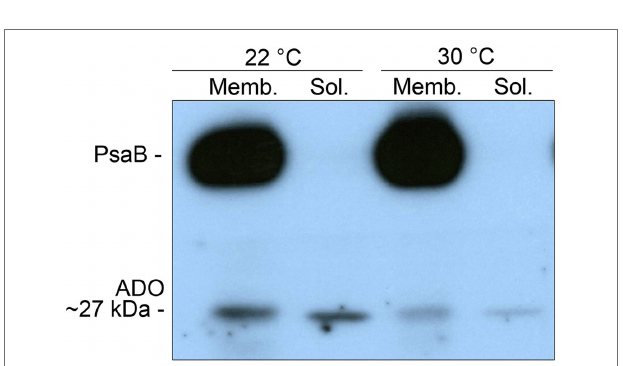
FIGURE 3 | Western blot analysis of ADO in the membrane fraction (Memb.) and the soluble fraction (Sol.) of Synechocystis sp. PCC 6803 cells cultivated at 22 ° C and 30 ° C for 4 days. The samples were loaded to the same final protein concentration (3 μ g) based on Bradford assay and analyzed using protein-specific antibodies against ADO, and the integral membrane reference protein PsaB. The analysis was carried out in four independent